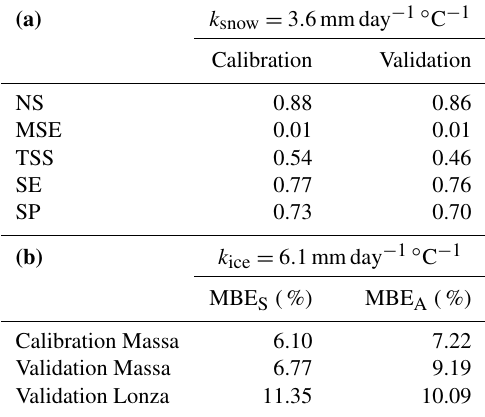
Table 2. (a) Calibrated snowmelt factor k snow and goodness-of-fit measures for validation and calibration periods: Nash–Sutcliffe ef- ficiency (NS), mean square error (MSE), true skill statistic (TSS), sensitivity (SE), and specificity (SP) for the entire upper Rhône Basin; and (b) calibrated ice-melt factor k ice and goodness-of-fit measures: mass balance error computed on June–October (MBE S ) and on the entire year (MBE A ) for the Massa and Lonza sub-basins.